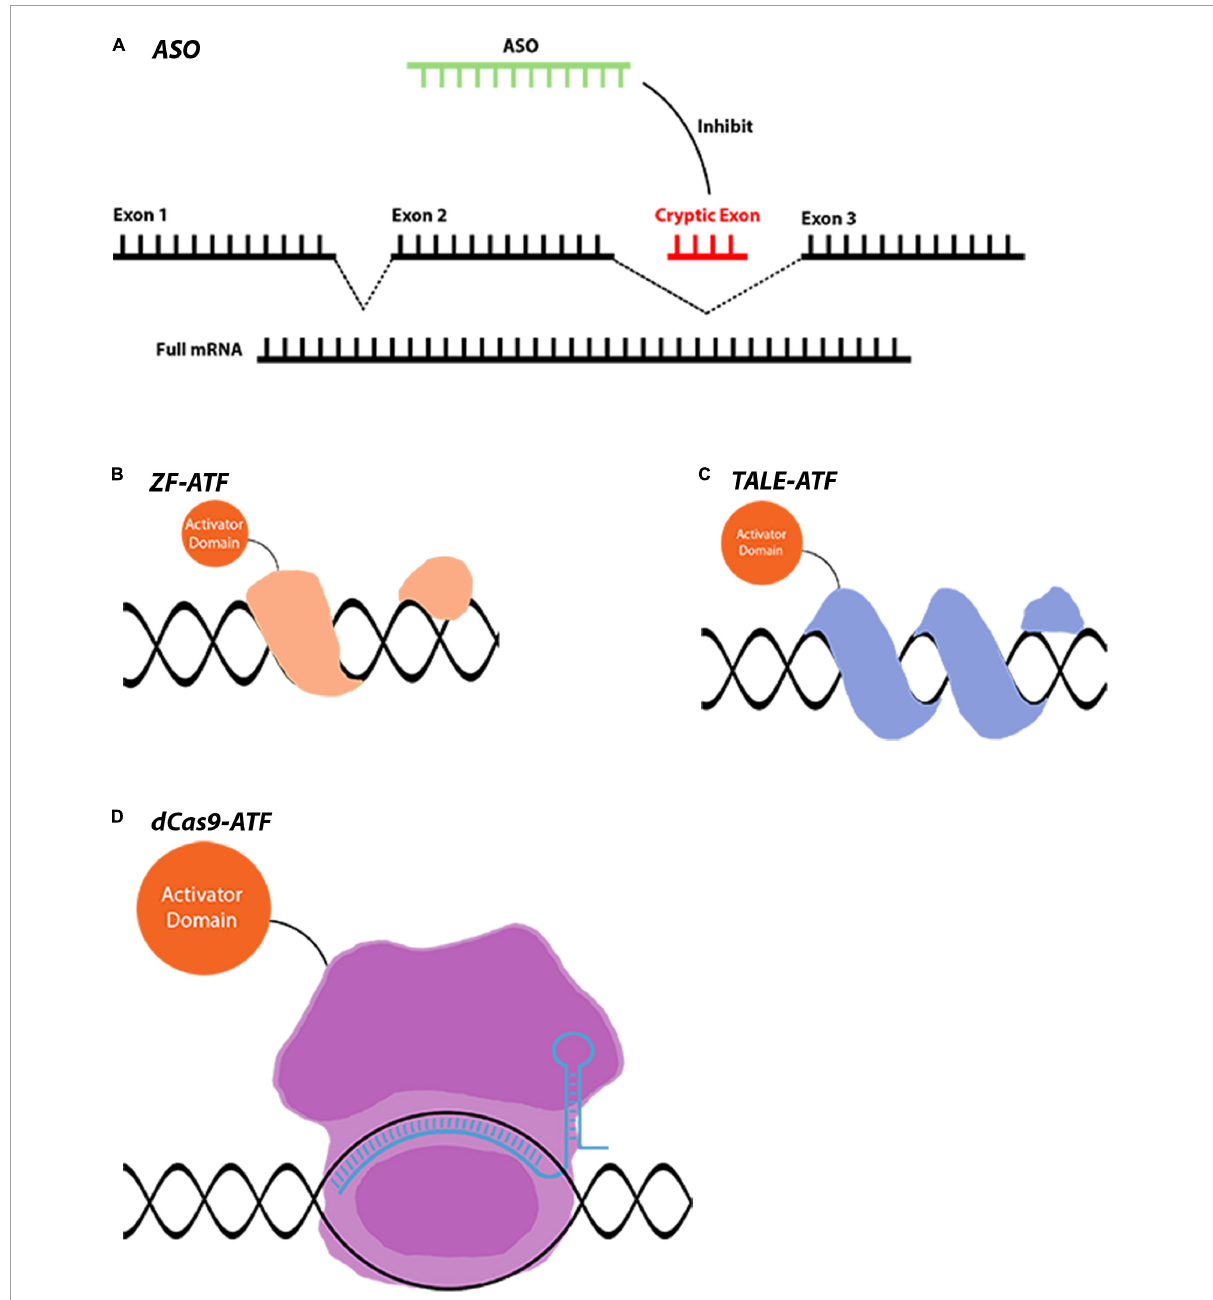
FIGURE2 Gene regulation tools that are used for indirect gene therapies. (A) AON-mediated splicing correction is used in LCA and many other diseases. AONs can act in different ways such as gene silencing and miRNA modulation. (B–D) ATFs are novel tools that can downregulate or upregulate a gene to achieve a therapeutic effect. Conjugation of different domains to achieve varying levels of gene regulation makes these tools extremely versatile. Images are modified from crystal structures of proteins (Protein Data Bank: